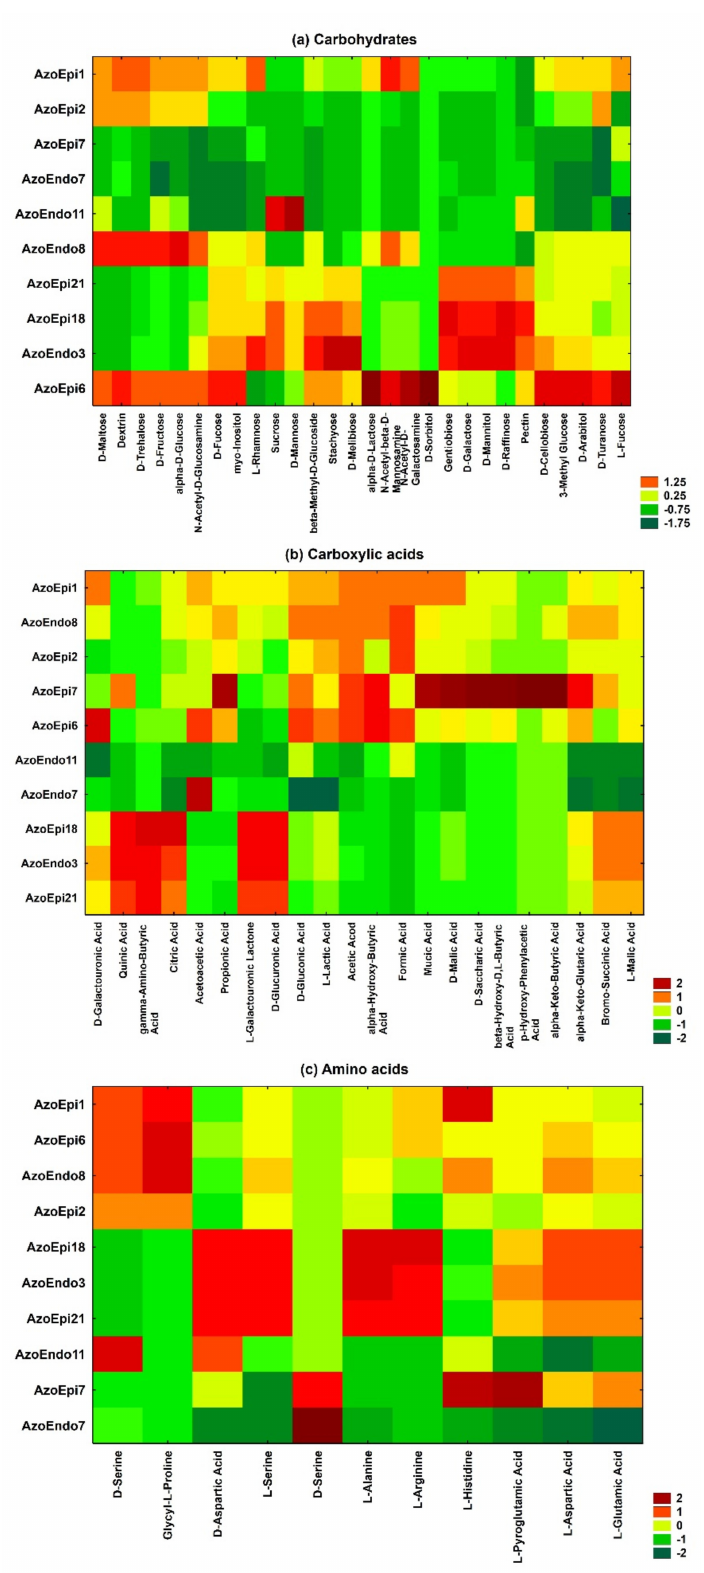
Figure 2. Heatmap of 10 strains showing metabolic profiles for ( a ) carbohydrates, ( b ) carboxylic acid, and ( c ) amino acids after 48 h of incubation. The relative use of selected substrates is depicted by color intensity, based on the legend next to the figure. The highest and lowest consumption rates are indicated by red and green colors,